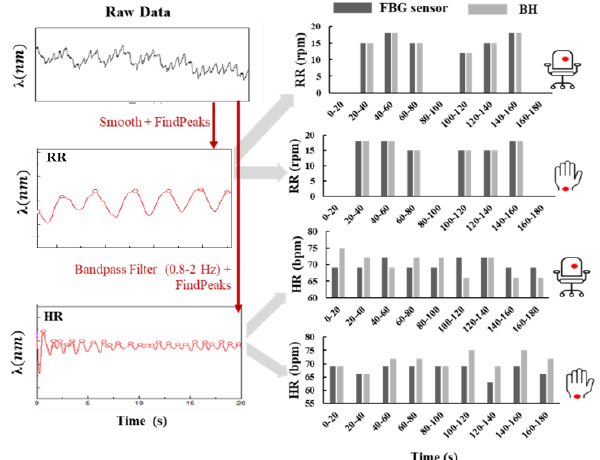
Fig. 3: Example segments for a section of the office chair data acquired (left); RR and HR results represented as bar graphs for two testes